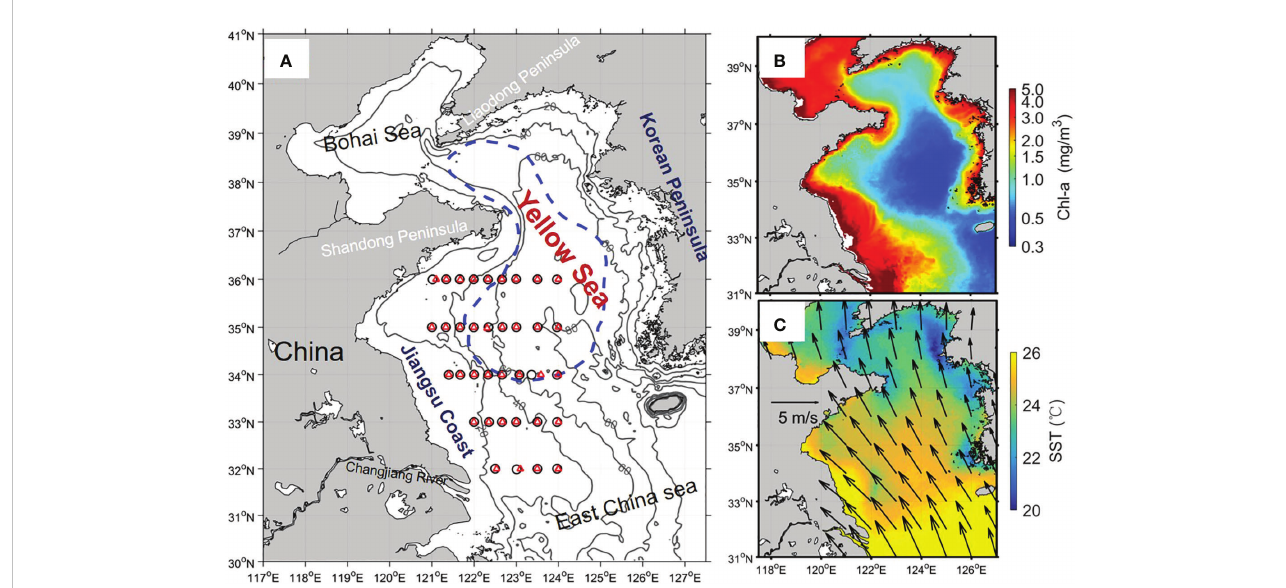
FIGURE 1 (A) A map of the Yellow Sea with isobaths and sampling stations (Black circles: July 2018; red triangles: August 2015). The Yellow Sea Cold Water Mass (YSCWM) scaled by the blue dash-line is de fi ned as the 10 °C isotherms in the bottom layer in summer, (Zhang et al., 2008). (B) The climatological mean of sea surface chlorophyll-a (Chl-a) in summer. (C) The climatological mean SST (color) and wind (arrows) in